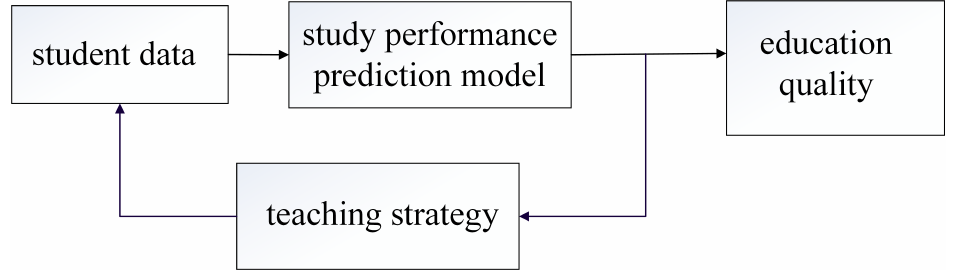
Figure 1. The flow chart to ensure the SHSE based on the student performance